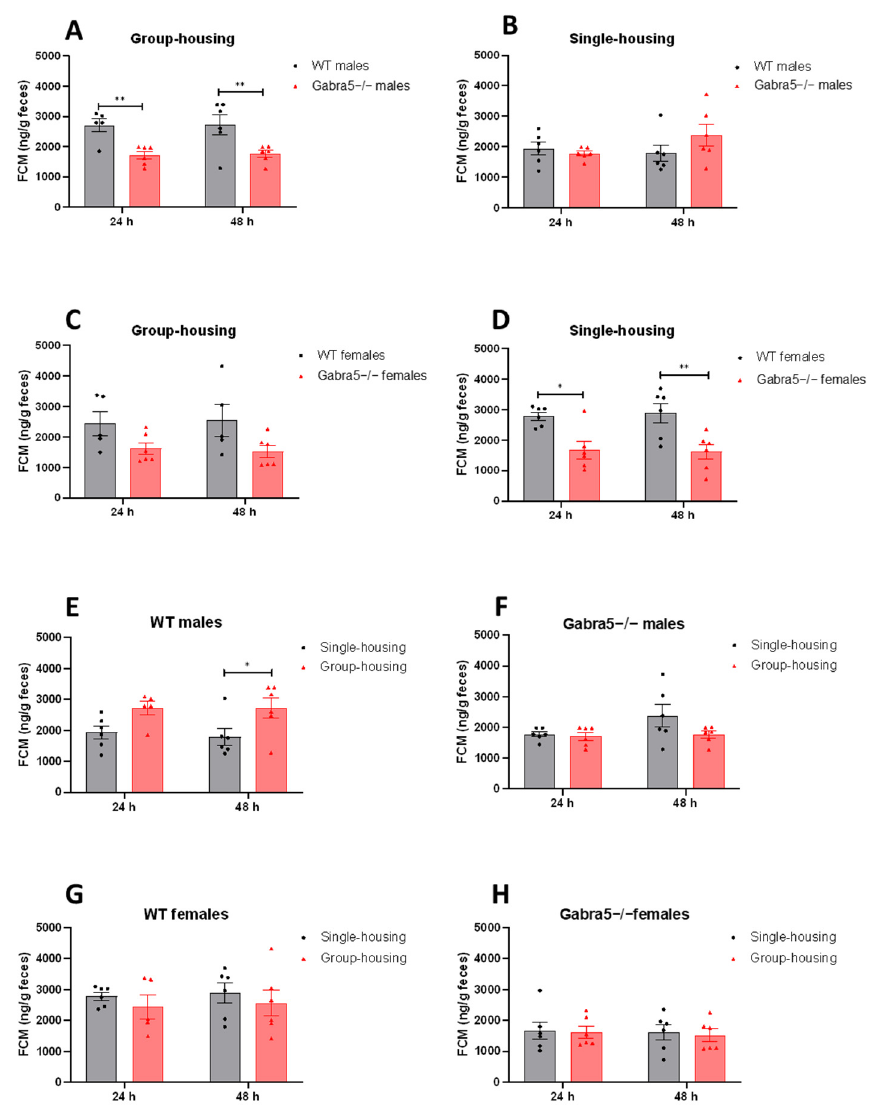
Figure 2. Fecal corticosterone metabolites concentration and effects of housing. ( A – D ) FCM concen- trations depending on genotype within same housing-conditions. ( E – H ) Same FCM concentrations but depending on housing within sex and genotype. Two-way ANOVA with dependent measure- ments with Bonferroni’s post-hoc test, n = 6. All graphs were depicted with mean ± SEM. Significant effects of genotype or housing are indicated as * p < 0.05 and ** p < 0.01.